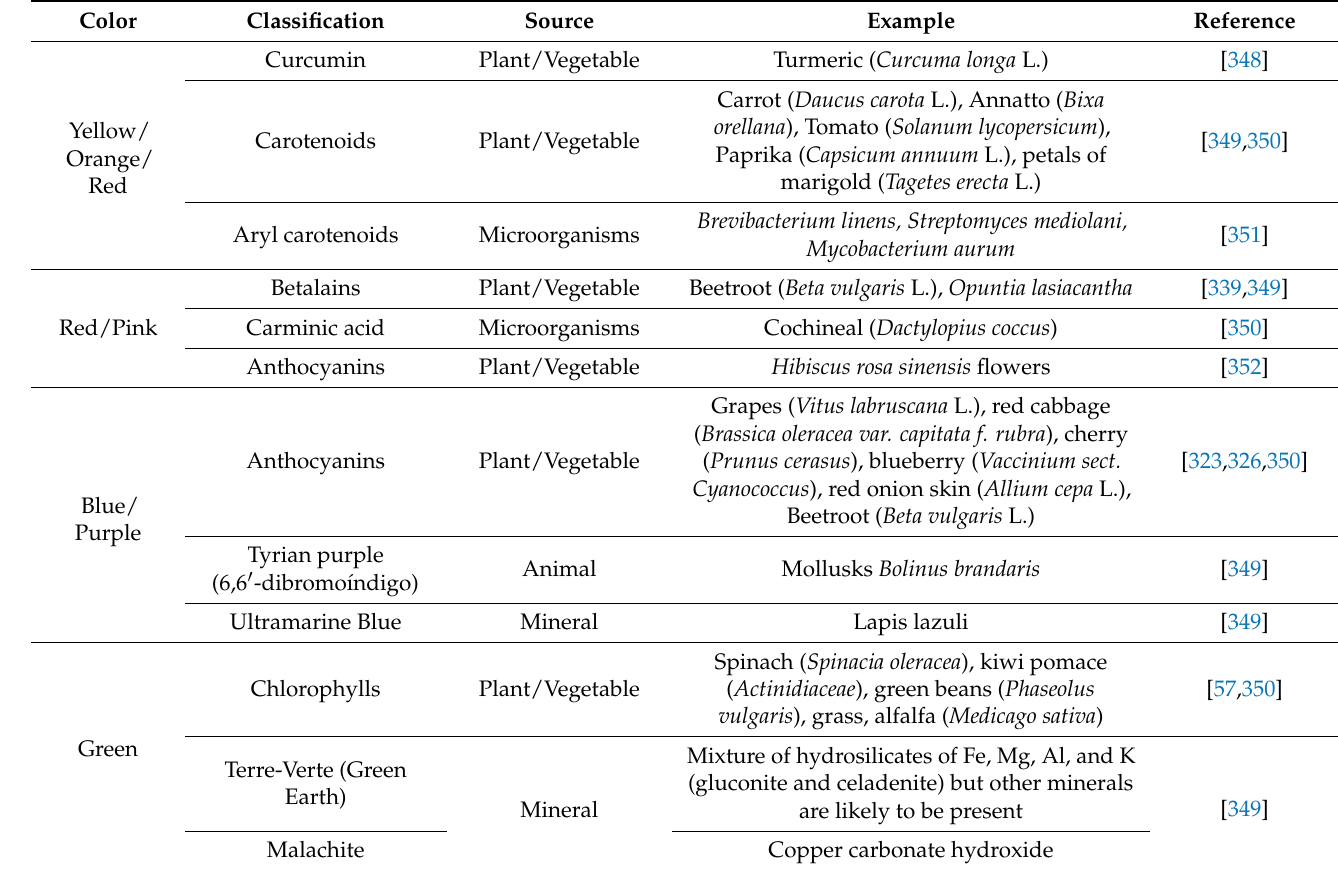
Table 3. Classification of natural dyes according to their chemical structure and